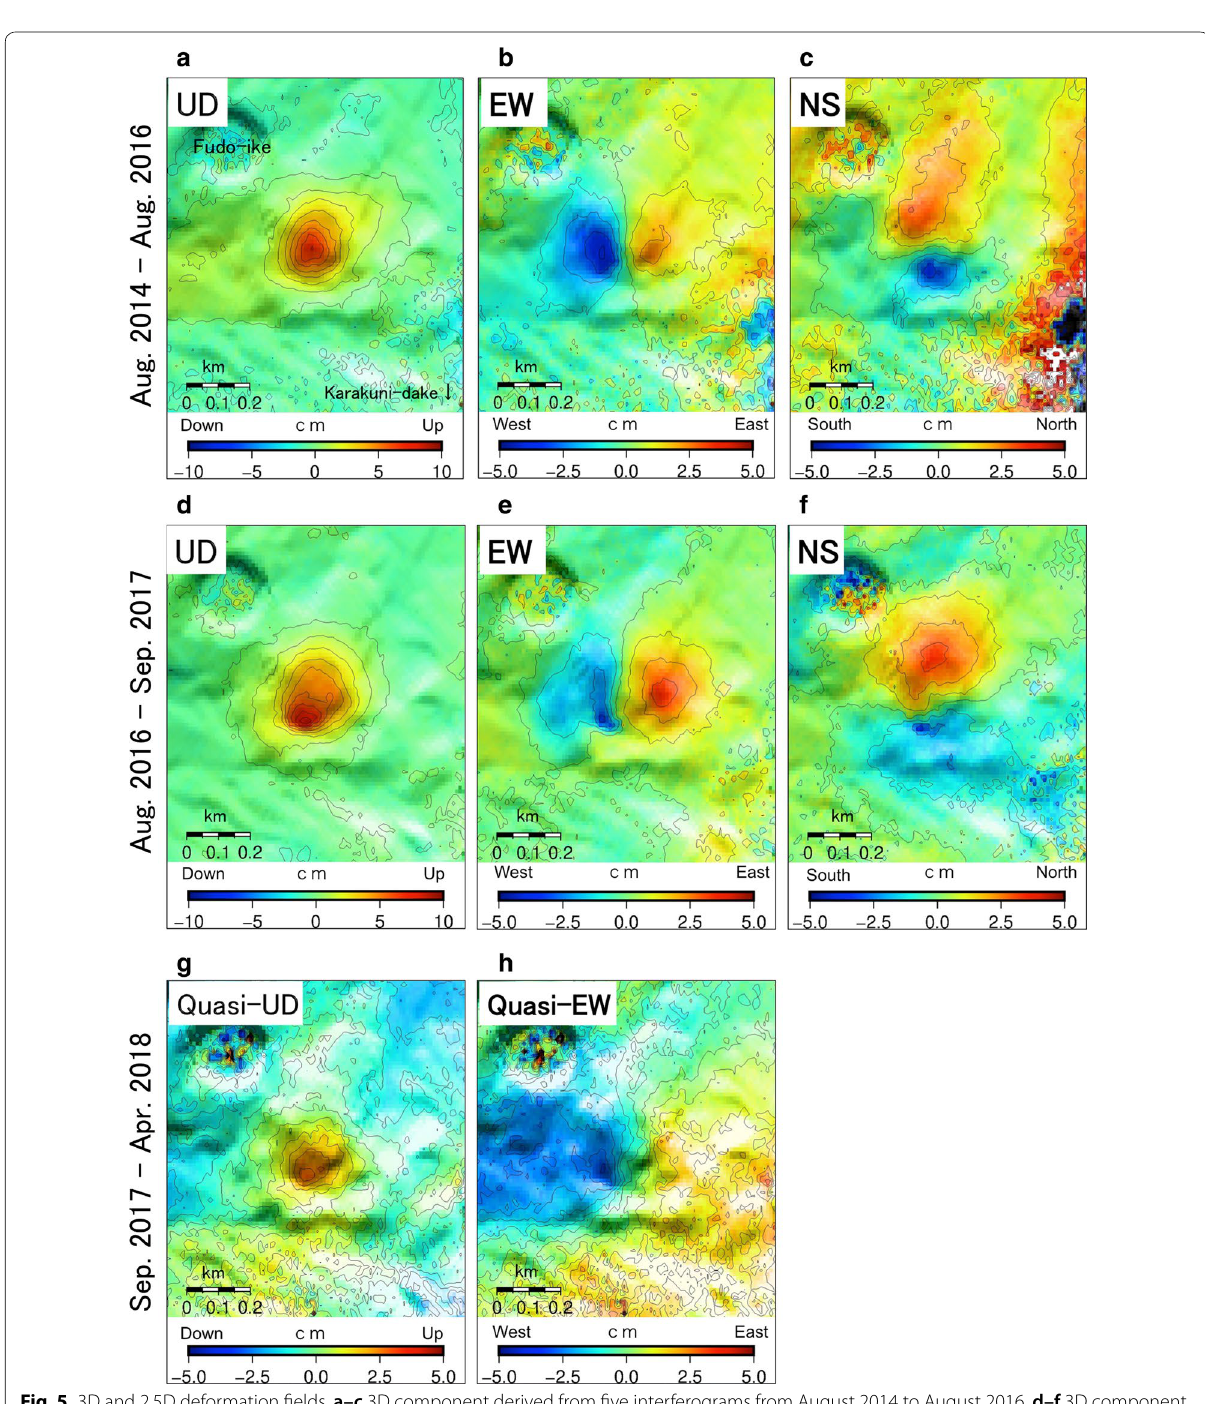
Fig. 5 3D and 2.5D deformation fields. a–c 3D component derived from five interferograms from August 2014 to August 2016. d–f 3D component derived from five interferograms from August 2016 to September 2017. g–h 2.5D component derived from two interferograms from September 2017 to April 2018. Contour intervals are 1 cm in a – f and 0.5 cm in g –